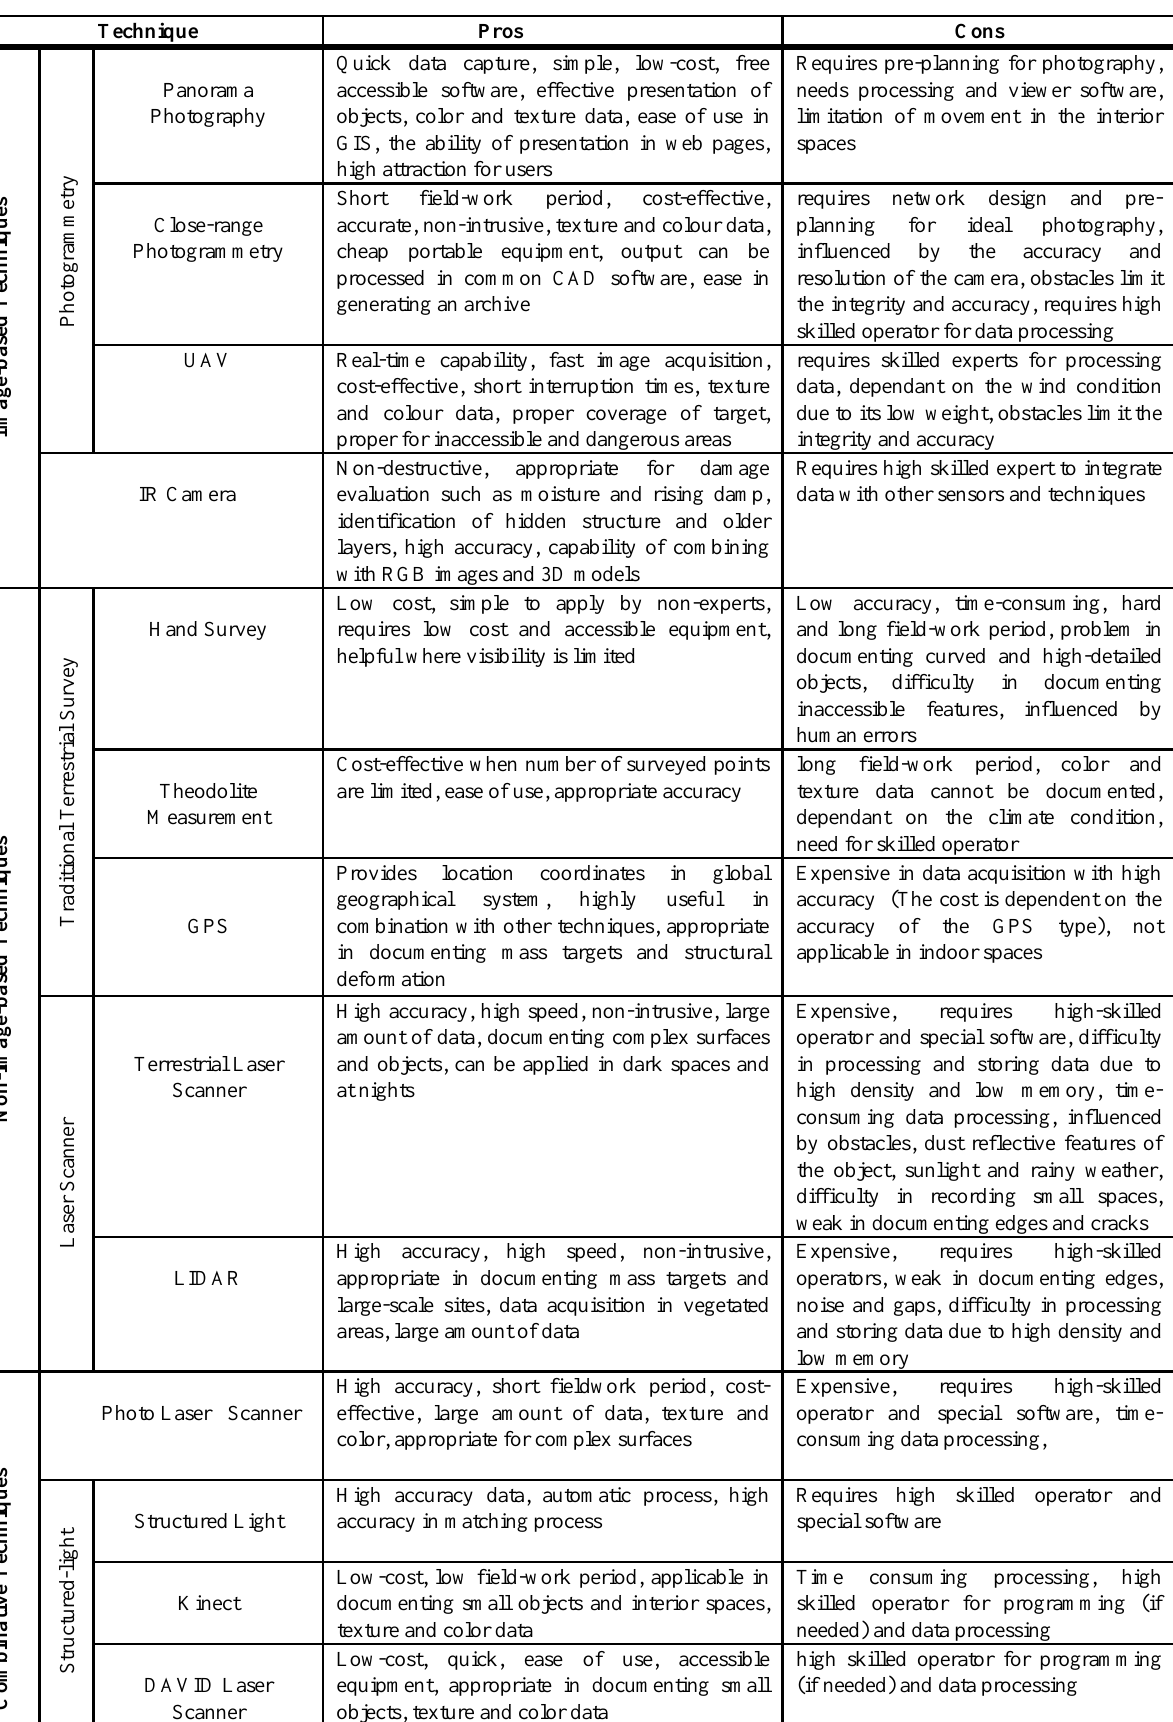
Table 1. Documentation Techniques; Pros and